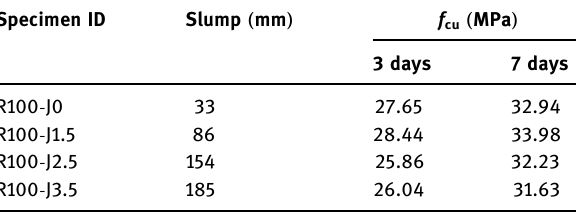
Table 5: Workability and compressive strength Specimen ID